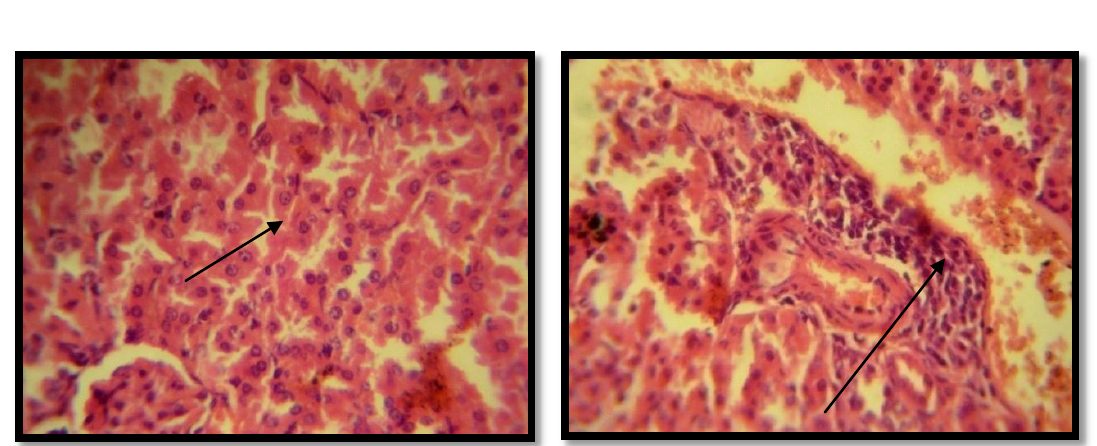
Figure 3: Kidney of the mouse treated with16mg/kgbw for 1month showing acute cellular swelling of epithelial cells lining of cortical